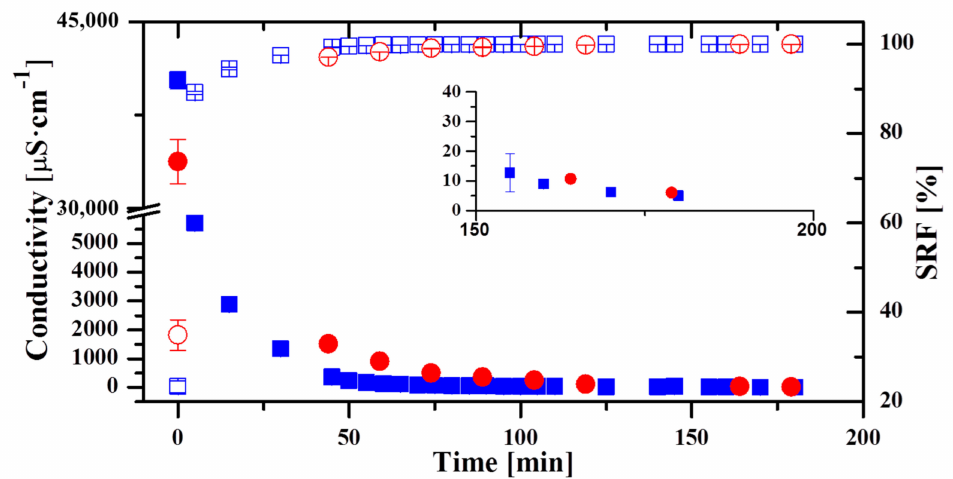
Figure 2. Permeate conductivity and Salt Rejection Factor (SRF) obtained in two typical days of operation with the module Oryx 150. Blue squares: conductivity of day 1; red circles: conductivity of